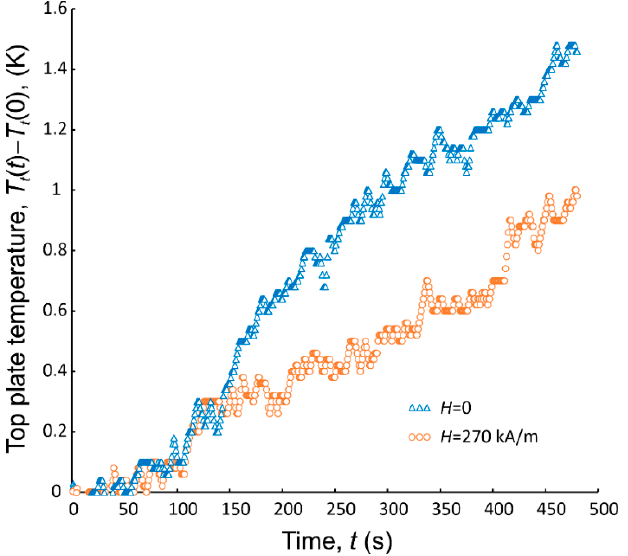
Figure 6. The temperature of the top (passive) aluminum plate of the cell as a function of time after heating is turned on. The results obtained in the absence and under the influence of a magnetic field are shown.